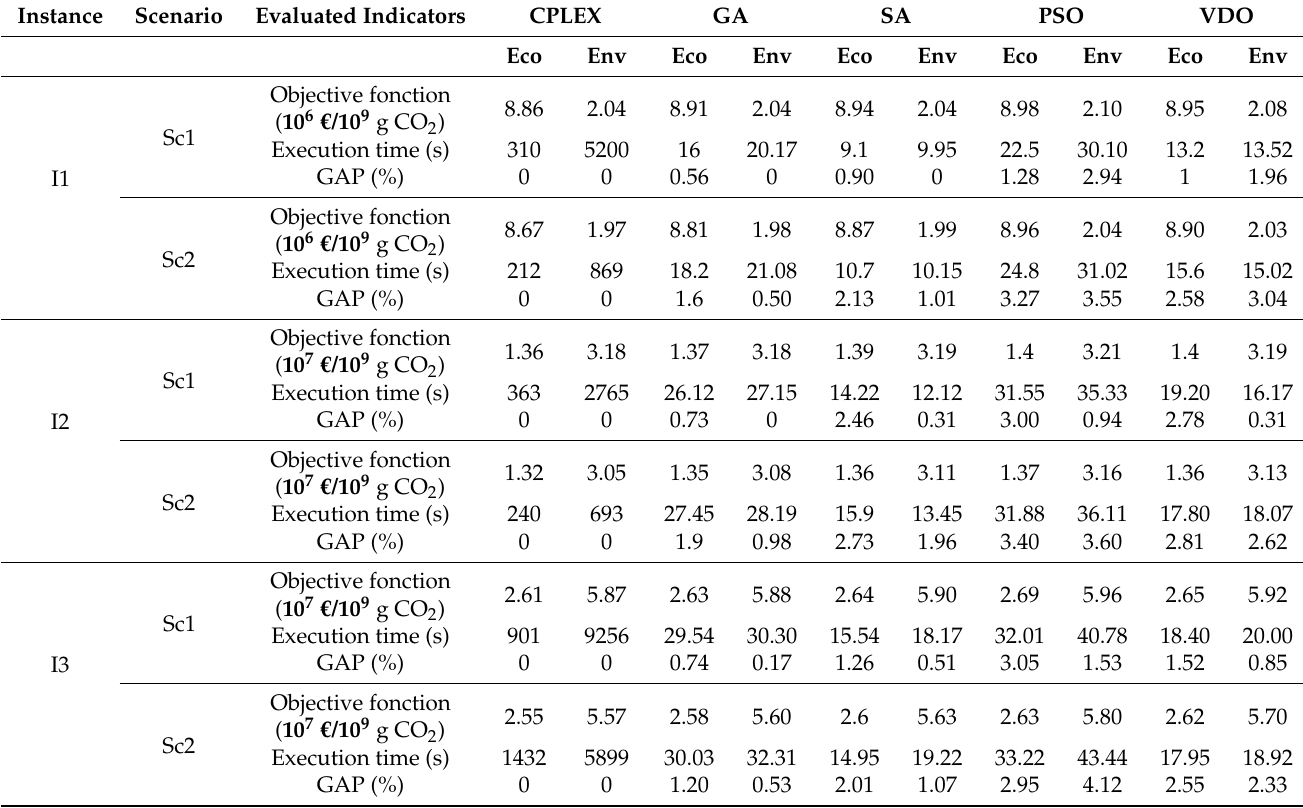
Table A8. Results of the instances in the scenarios obtained by the different resolution